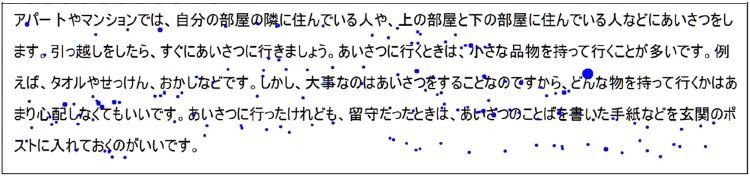
Example of recording where the reader keeps reading smoothly: There is no fixation agglomeration and the fixation duration are small (dot diameter).However, the reader did not understand the text very well and gave a wrong answer for the comprehension question.